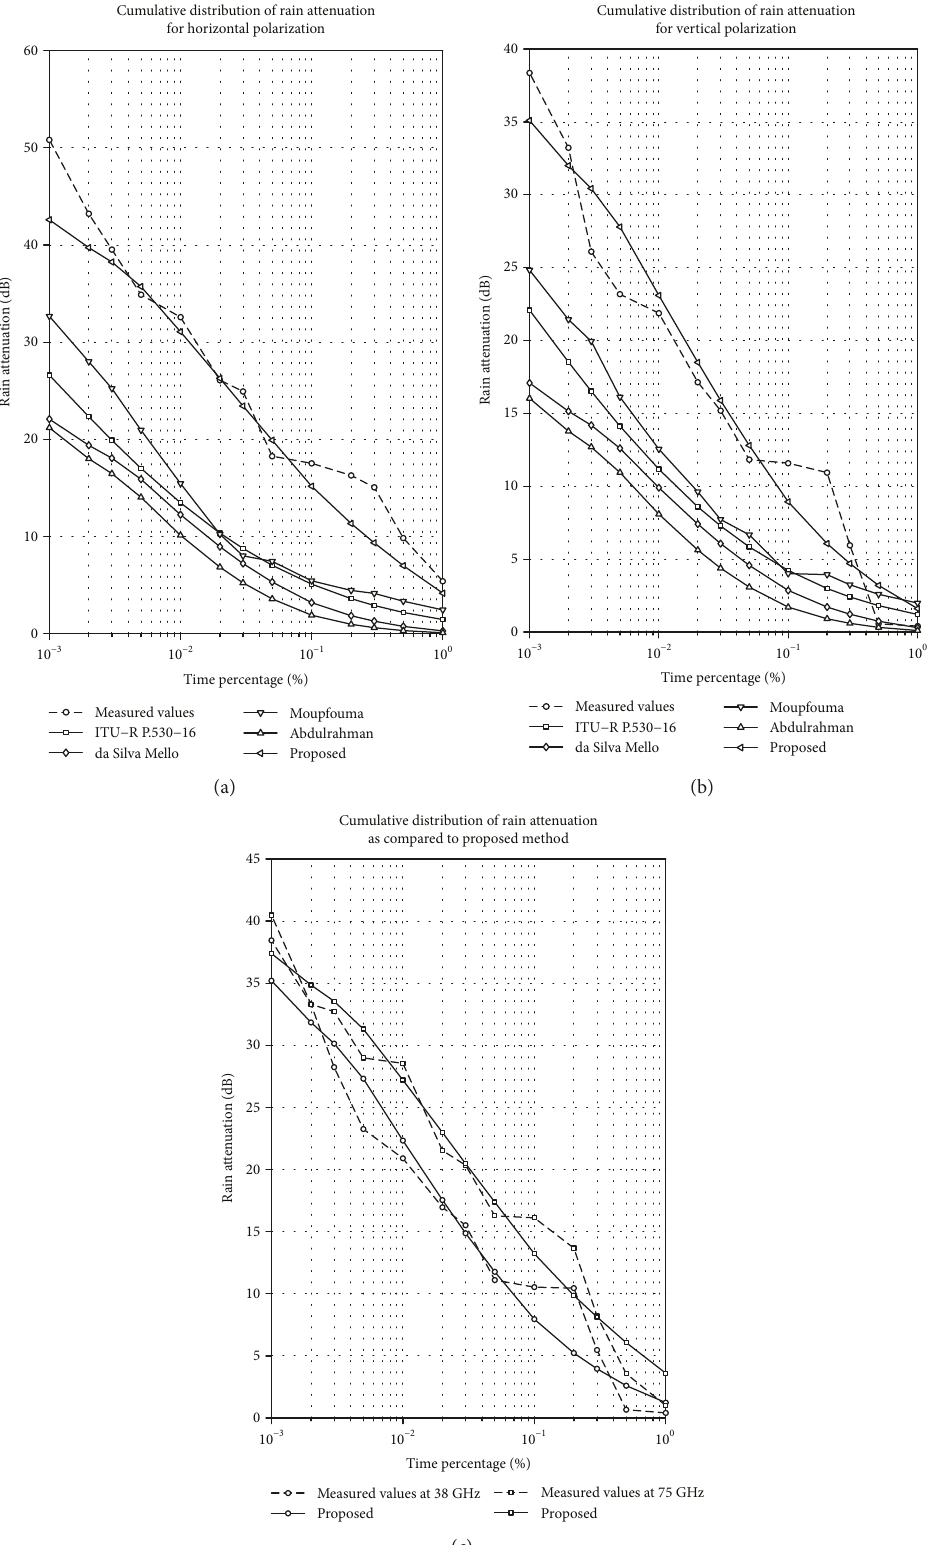
Figure 9: (a) Comparison of measured and predicted attenuation for horizontal polarization. (b) Comparison of measured and predicted attenuation for vertical polarization. (c) Comparison of measured and predicted attenuation for 38 and 75 GHz